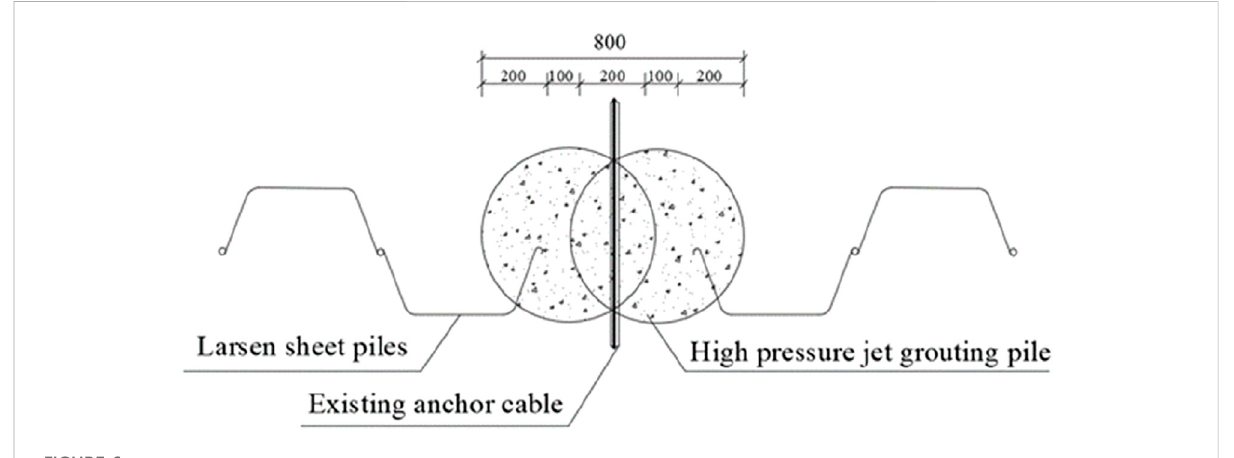
FIGURE 6 Overlapping of jet grouting piles and steel-sheet piles.